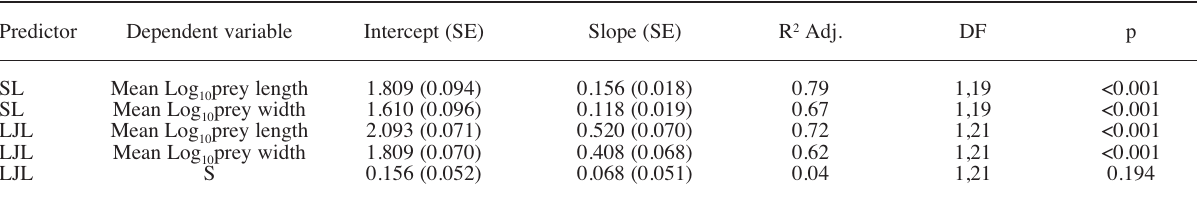
T ABLE 2. – Weighted regression parameters and statistics for relationships between larval SL and LJL (mm) vs prey length and width (μm). SE is 1 Standard Error. DF are degrees of freedom. S is niche breadth.